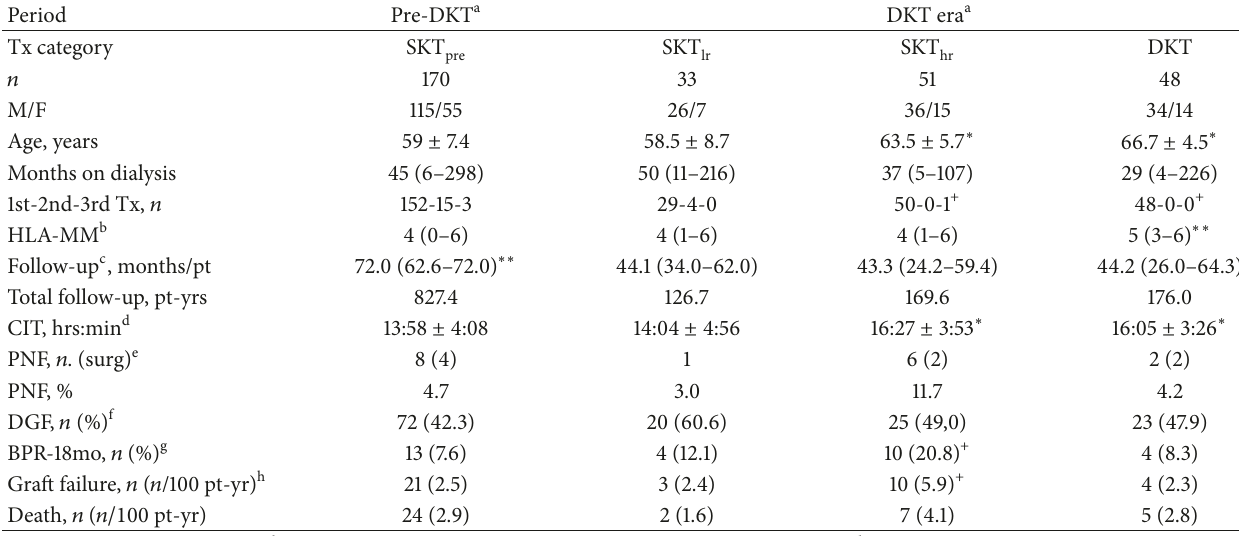
a Pre-DKT, DKT era: see Table 2. b Mismatches on HLA loci A, B and DRB1; c time to event or censoring; d cold ischemia time; e graft primary nonfunction (number of surgical failures in parenthesis); f Delayed graft function (need for dialysis in the first week post-Tx); g biopsy-proven rejection within 18 months after transplant; h PNF and graft losses over time. Statistical differences: ∗ 𝑃 < 0.01 versus SKT pre and SKT lr ; + P < 0.05 versus SKT pre ; ∗∗ P < 0.05 or less versus all other